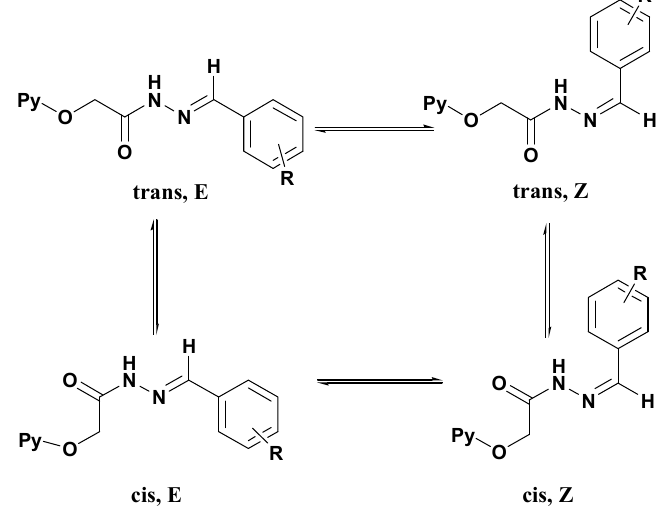
Figure 2. E/Z geometrical isomers and cis/trans conformers of compounds 8a – c . In Scheme 3 , condensation of the hydrazide 6 with acetylacetone or ethyl acetoacetate in ethanol/glacial acetic acid mixture (2:1) furnished the corresponding 3,5-dimethylpyrazole 11 and the pyrazolinone derivative 12 , respectively. Heating 6 with methyl 2-cyano-3,3-bis(methyl-sulfanyl) acrylate or [bis(methylsulfanyl)methylene]malononitrile in dry DMF following reported reaction conditions [54] yielded the proposed 5-amino-3-methylsulfanyl-4-substituted pyrazolyl derivatives 13a , b in moderate yield. On the other hand, refluxing 6 with carbon disulphide in ethanolic potassium hydroxide afforded the oxadiazolyl derivative 14 .